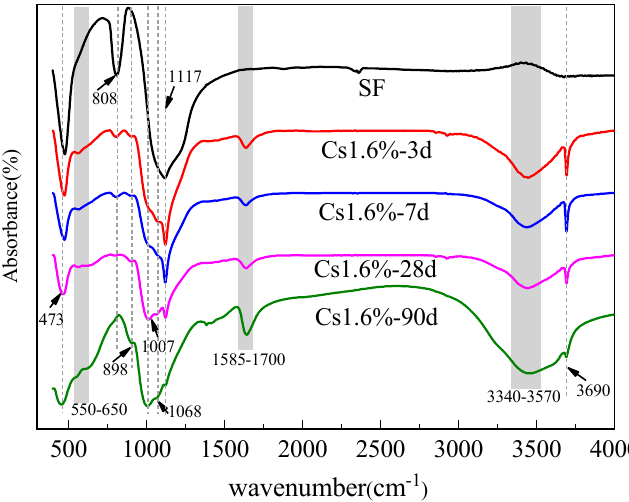
Figure 5. Fourier transform infrared spectra of the silica fume and M–S–H cement-solidified body with 1.6 wt % Cs + after 3, 7, 28 and 90 d.